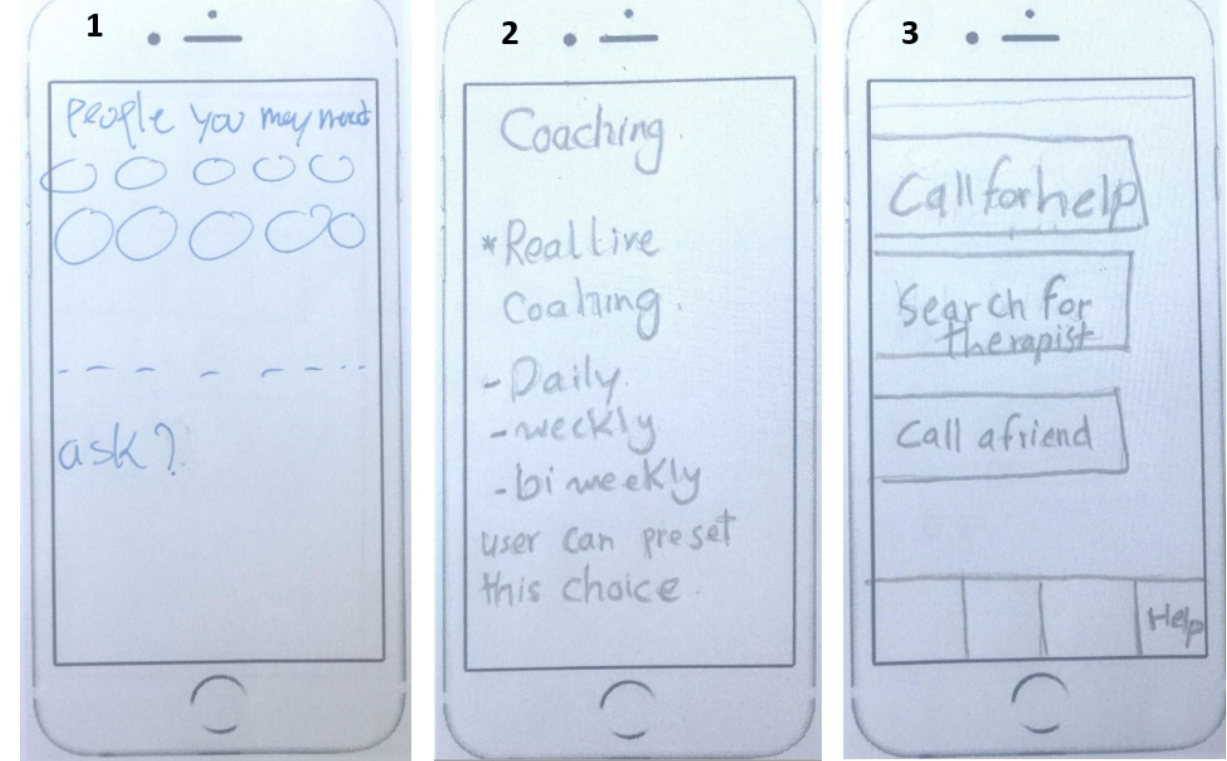
Figure 5. Three implementation ideas of a live support feature: (1) including therapists that users can contact and the ability to text them; (2) the